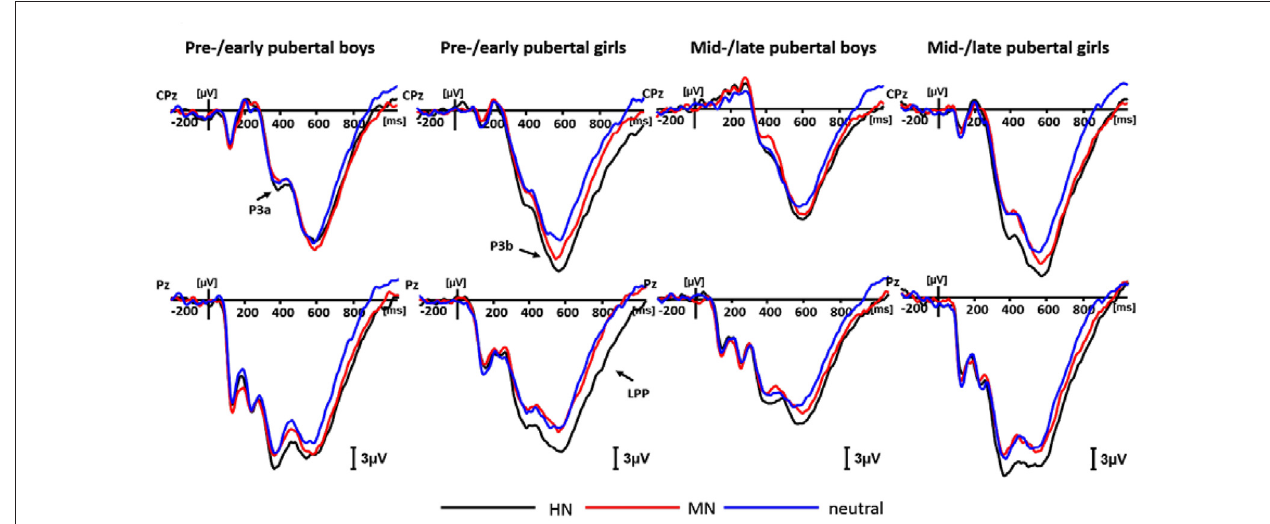
FIGURE 4 | Averaged event-related potentials (ERPs) for each group during highly negative (HN; black lines), mildly negative (MN; red lines) and neutral (blue lines) conditions in the negative block.